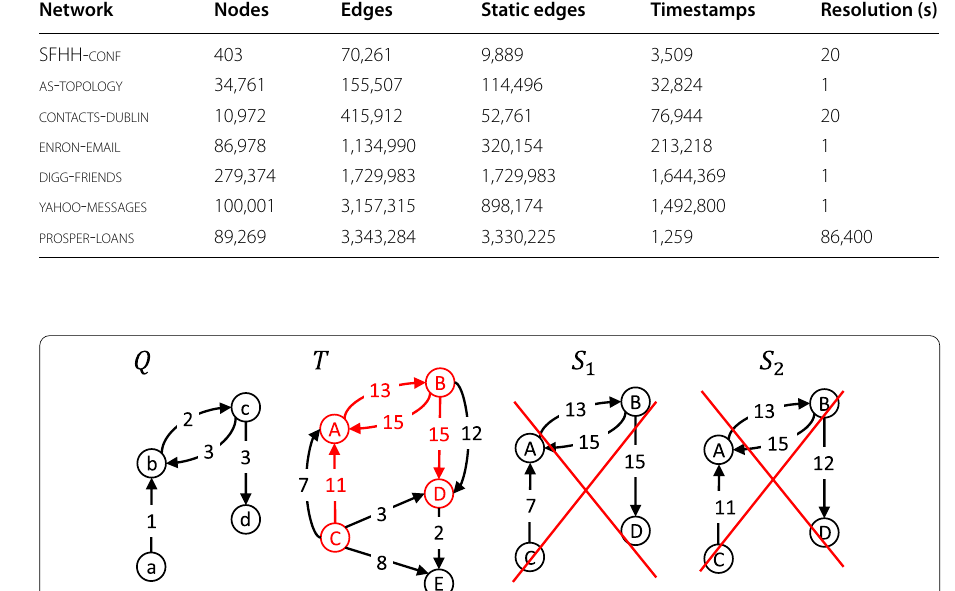
Table 1 Dataset of real networks used for the experiments Network